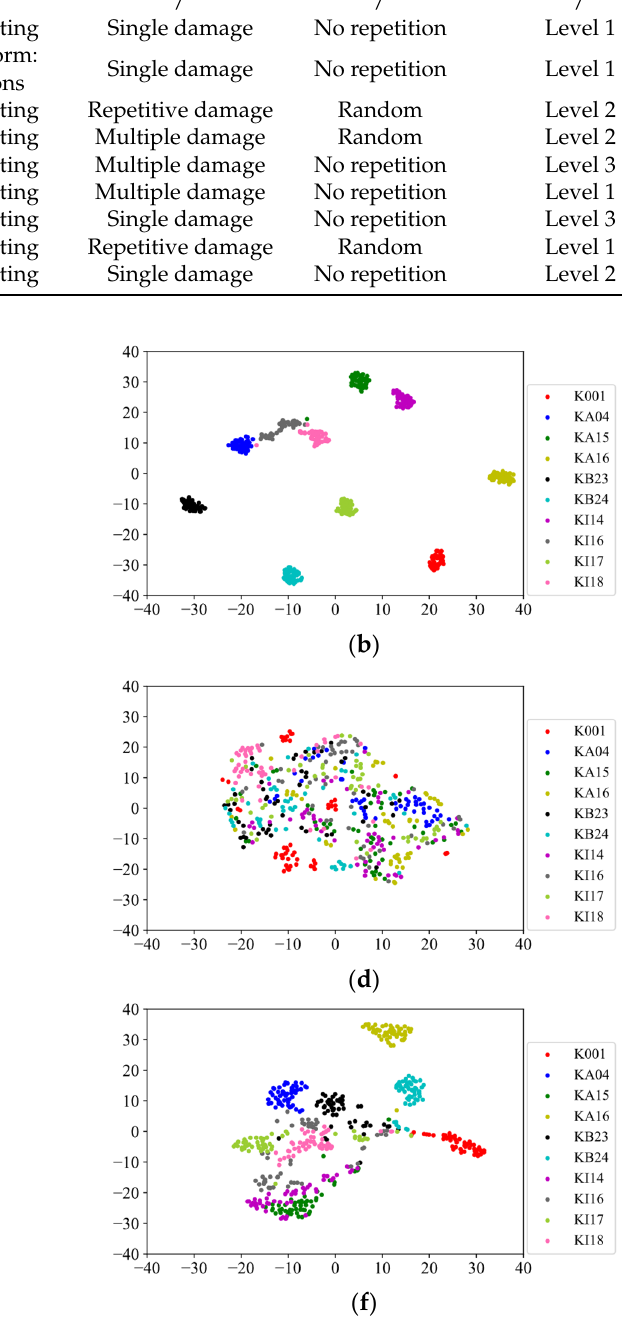
Figure 9. The visualization of feature extractors on labeled bearing dataset 2. ( a ) SMoCo; ( b ) labeled pretraining; ( c ) Wang; ( d ) SimCLR; ( e ) BYOL; ( f ) MoCo.